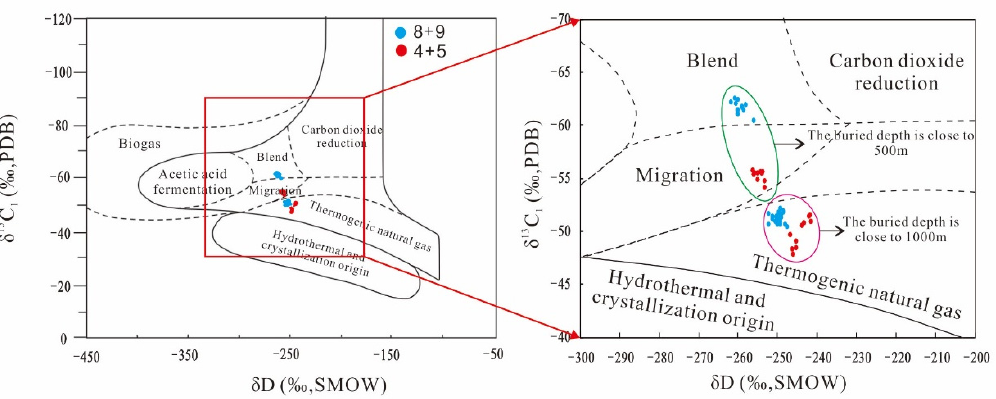
Figure 5. Genetic type discrimination map of CBM. (C 1 stands for CH 4 ) (modified from [31]).